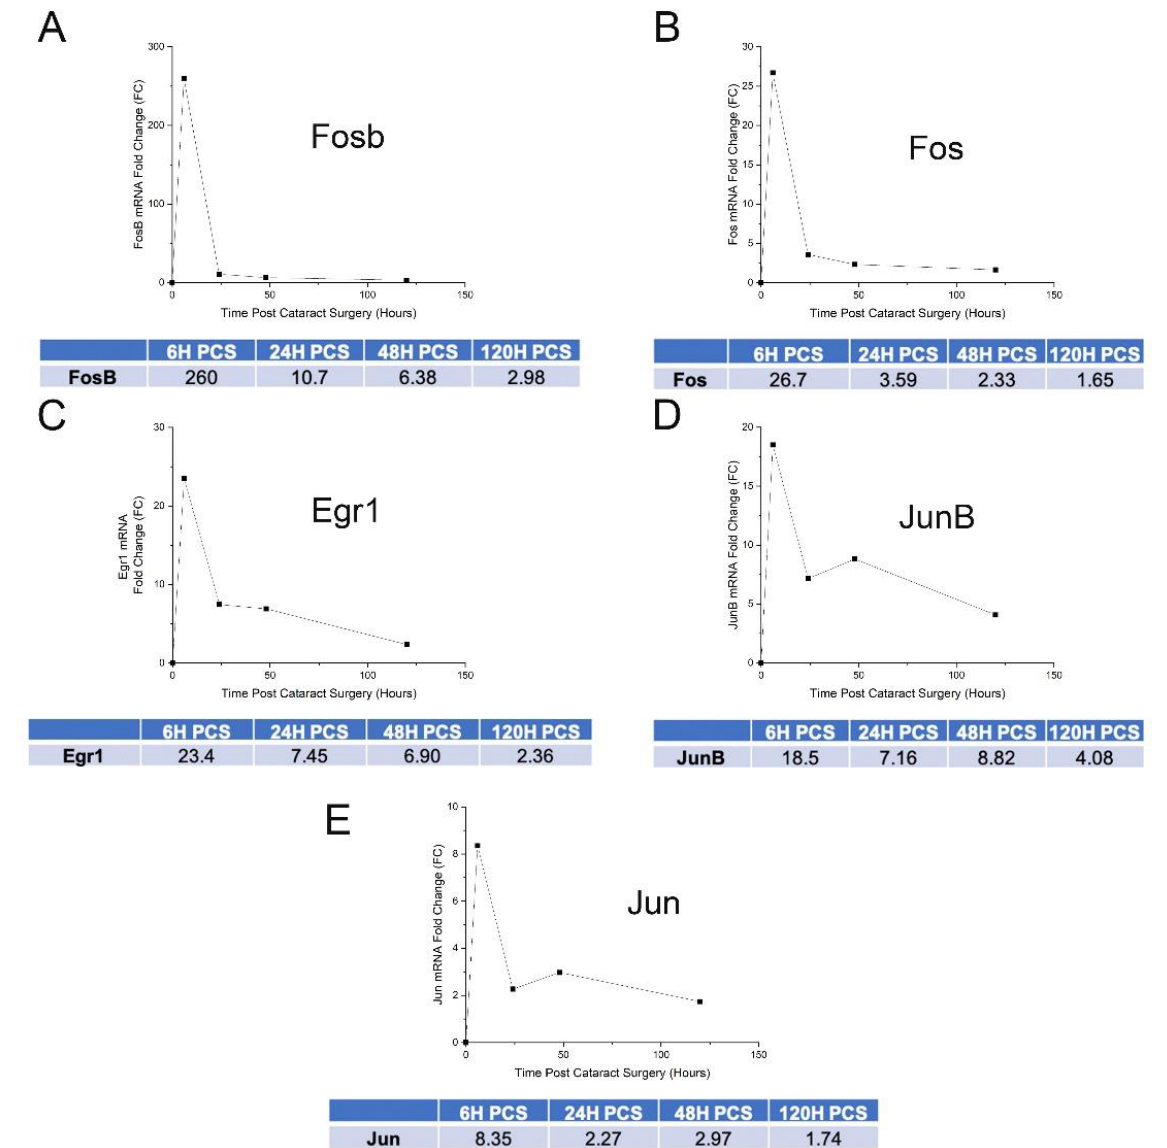
Figure 3. Expression dynamics of select IETFs as revealed by bulk RNAseq expression profiling performed between 0–120 h PCS. ( A ) mRNA expression time course for FosB. ( B ) mRNA expression time course for Fos (cFos). ( C ) mRNA expression time course for Egr1. ( D ) mRNA expression time course for JunB. ( E ) mRNA expression time course for Jun (cJun). The Y axis represents fold expression level in comparison to levels observed in naïve LECs.